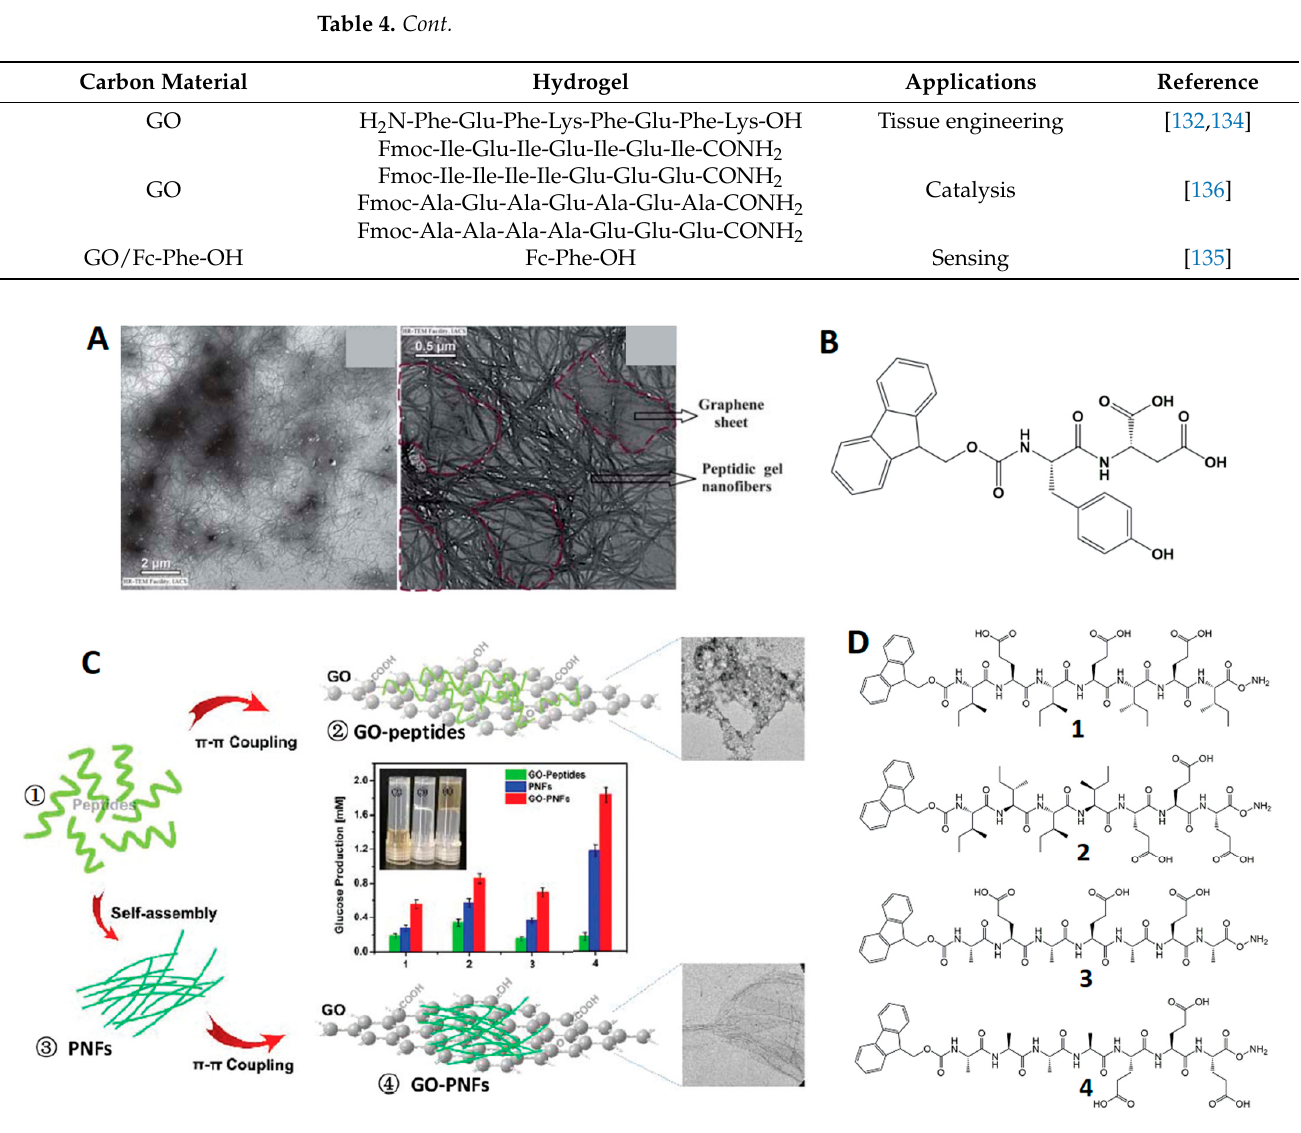
Figure 5. ( A ) TEM images of reduced graphene oxide-containing hydrogel obtained from ( B ) hydrogelator Fmoc-Tyr-Asp-OH. Adapted from reference [127] with permission from Royal Society of Chemistry, 2022. ( C ) Glucose production from the mixture of graphene oxide and peptides (GO-peptides), peptide hydrogels (PNFs) and graphene–peptide hydrogel composites (GO-PNFs); Adapted from reference [136] with permission from Royal Society of Chemistry, 2022. ( D ) Chemical structure of the peptide 1: Fmoc-Ile-Glu-Ile-Glu-Ile-Glu-Ile-CONH 2 , 2: Fmoc-Ile-Ile-Ile-Ile-Glu-Glu-Glu-CONH 2 , 3: Fmoc-Ala-Glu-Ala-Glu-Ala-Glu-Ala-CONH 2 , 4: Fmoc-Ala-Ala-Ala-Ala-Glu-Glu-Glu-CONH 2 . Table 4. Summary of advancements with peptide-based graphene–hydrogel composites. PDADMAC: poly diallyldimethylammonium chloride; PVP: polyvinylpyrrolidone; Amoc: N -an- thracenemethyloxycarbonyl; Fc: ferrocene.